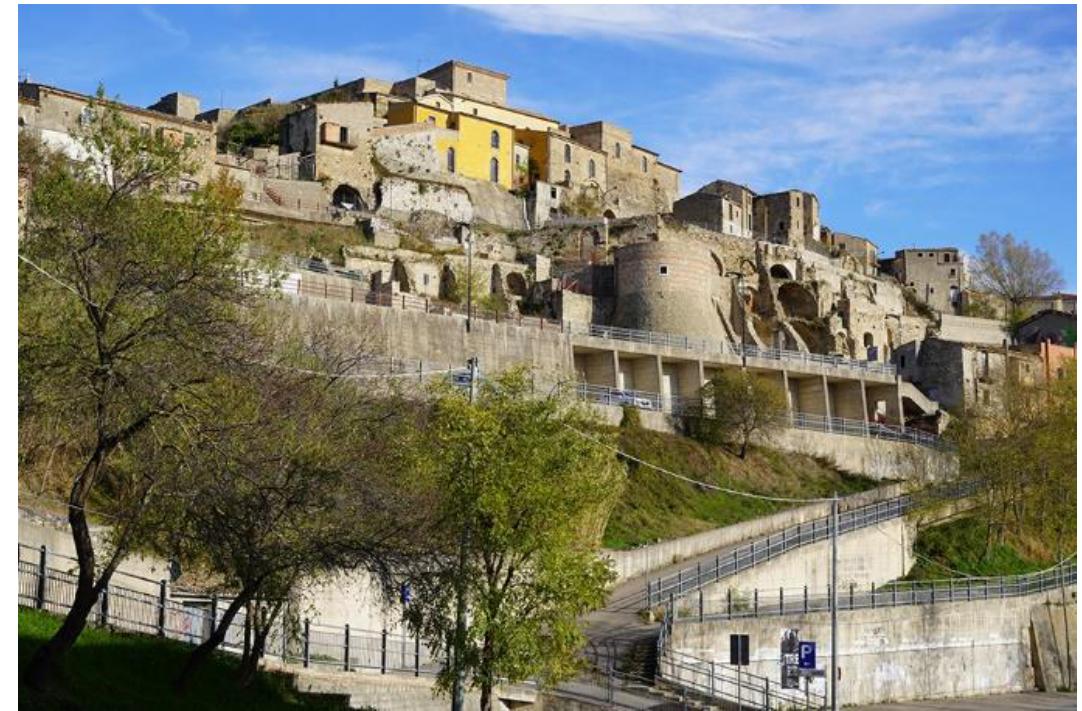
Figure 111. Calitri: historical centre, remains of some buildings that were recovered after the 1980 earthquake (photos by [35,36]).